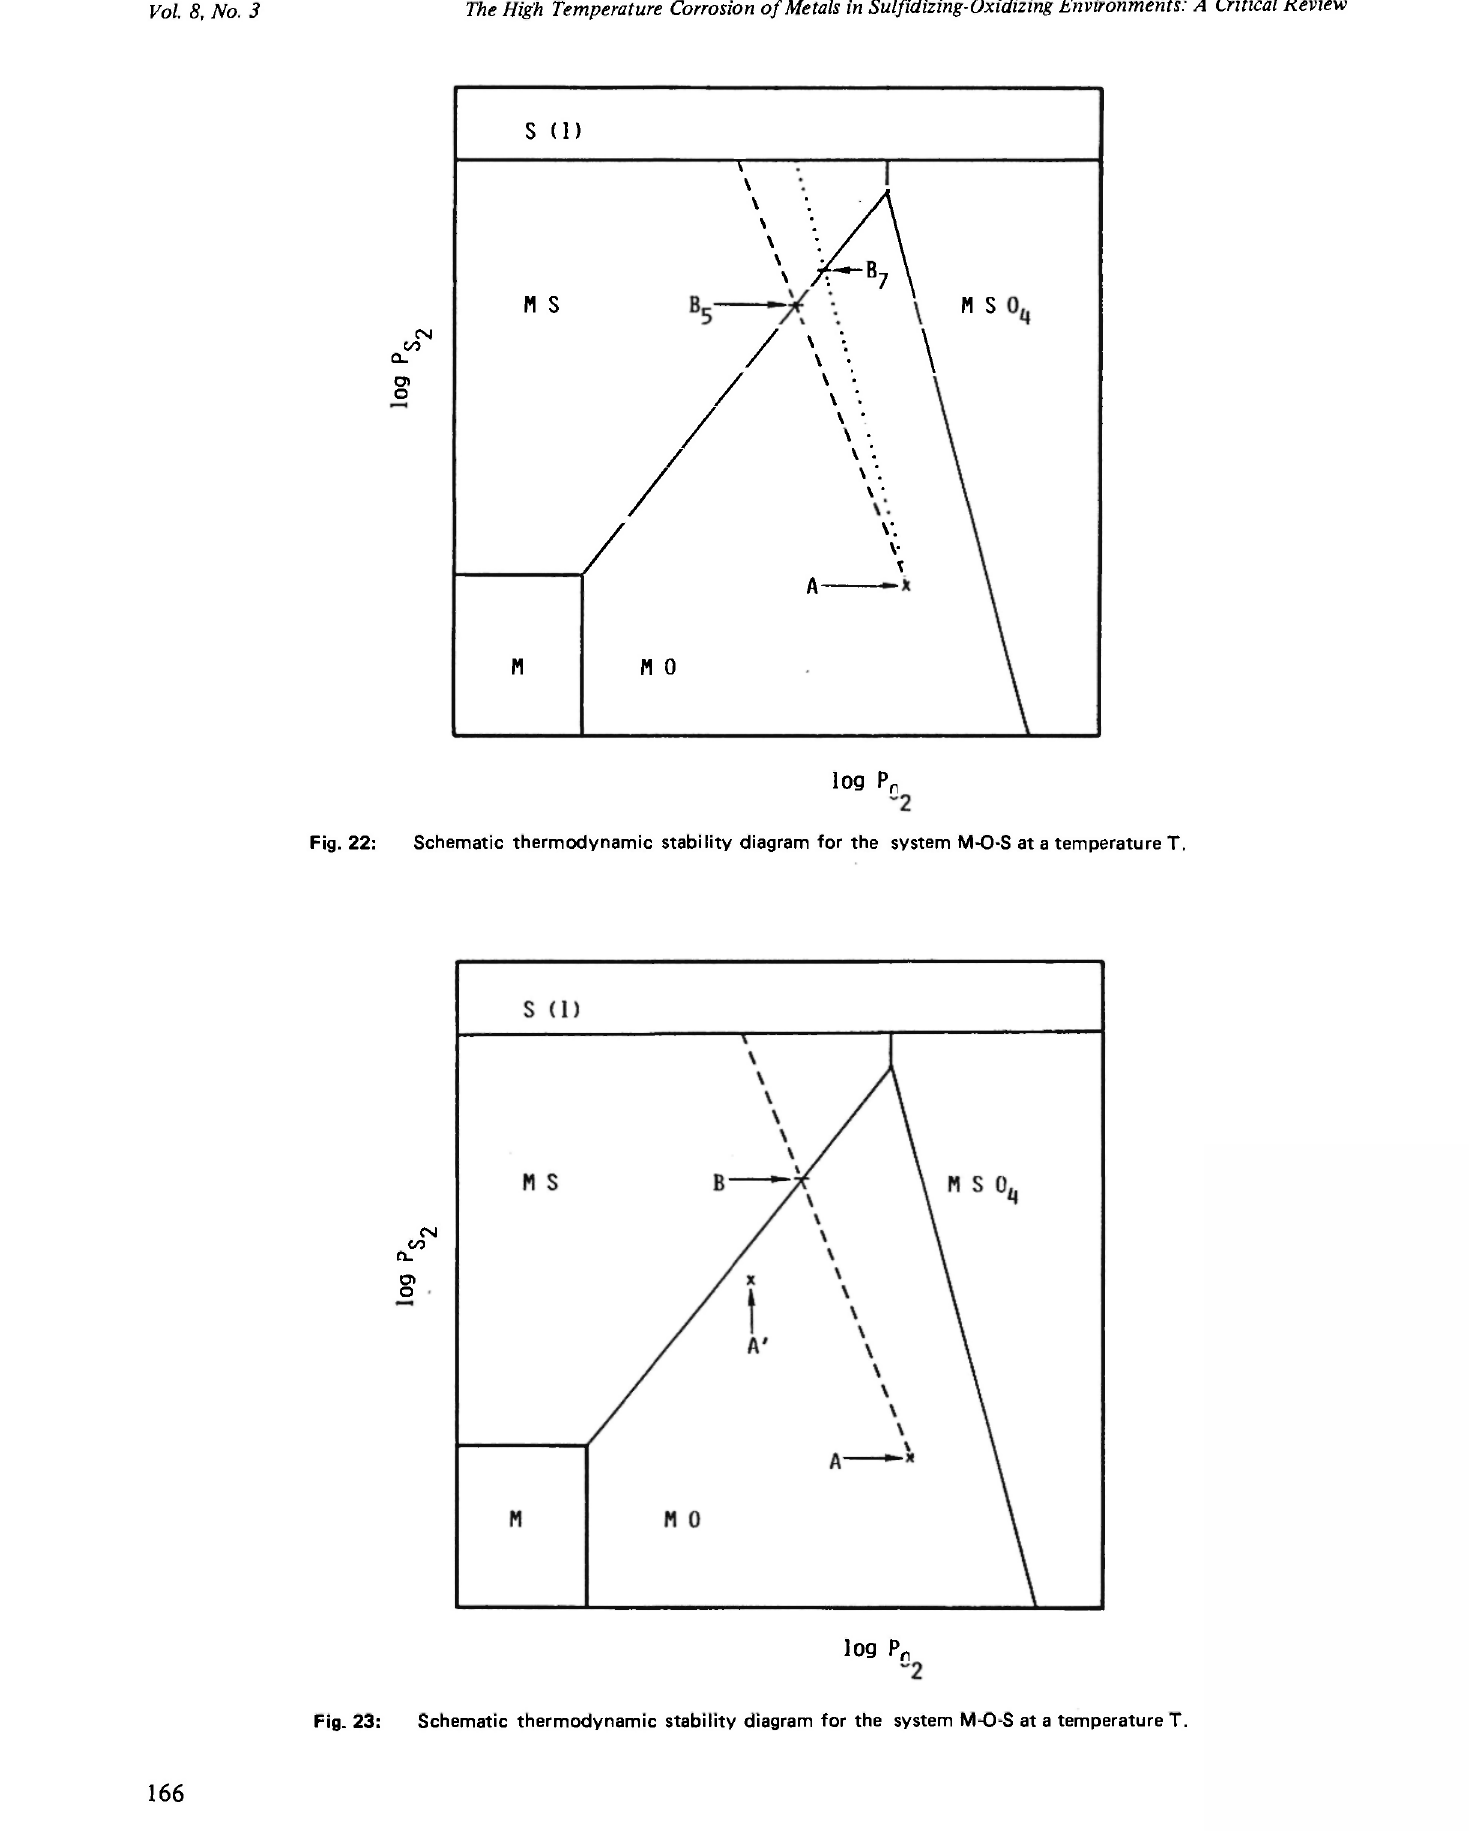
Fig. 23: Schematic thermodynamic stability diagram for the system M-O-S at a temperature